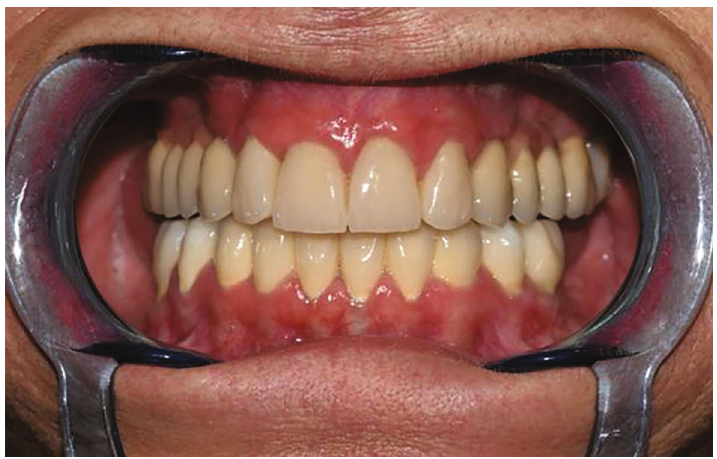
Figure 9: Intraoral status; the de fi nite prosthodontic work.